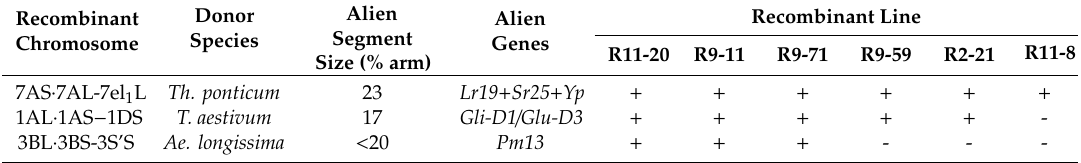
Table 1. Description of alien introgressions and recombinant lines used in the present study. Recombinant